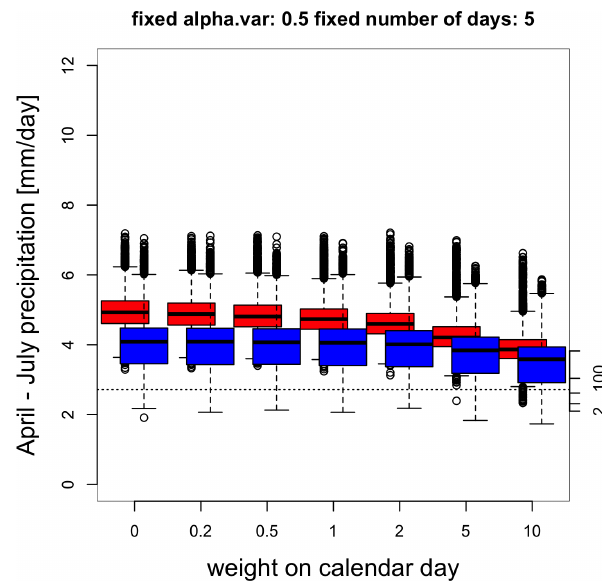
Figure A6. Distribution of April–July daily precipitation in obser- vations (white) and in simulations computed by the static (blue) and dynamic (red) generators as a function of α cal . The axis on the right indicates the probability of occurrence, assuming a normal distri- bution of daily precipitation with parameters estimated from the white boxplot. The horizontal dotted line corresponds to the ob- served daily precipitation in April–July 2016. The boxes of boxplots indicate the median ( q 50), lower ( q 25), and upper ( q 75) quartiles. The upper whiskers indicate min[max( T ), 1 . 5 × ( q 75 − q 25)]. The lower whisker has a symmetrical formulation. The points are the simulated values that are above or below the defined